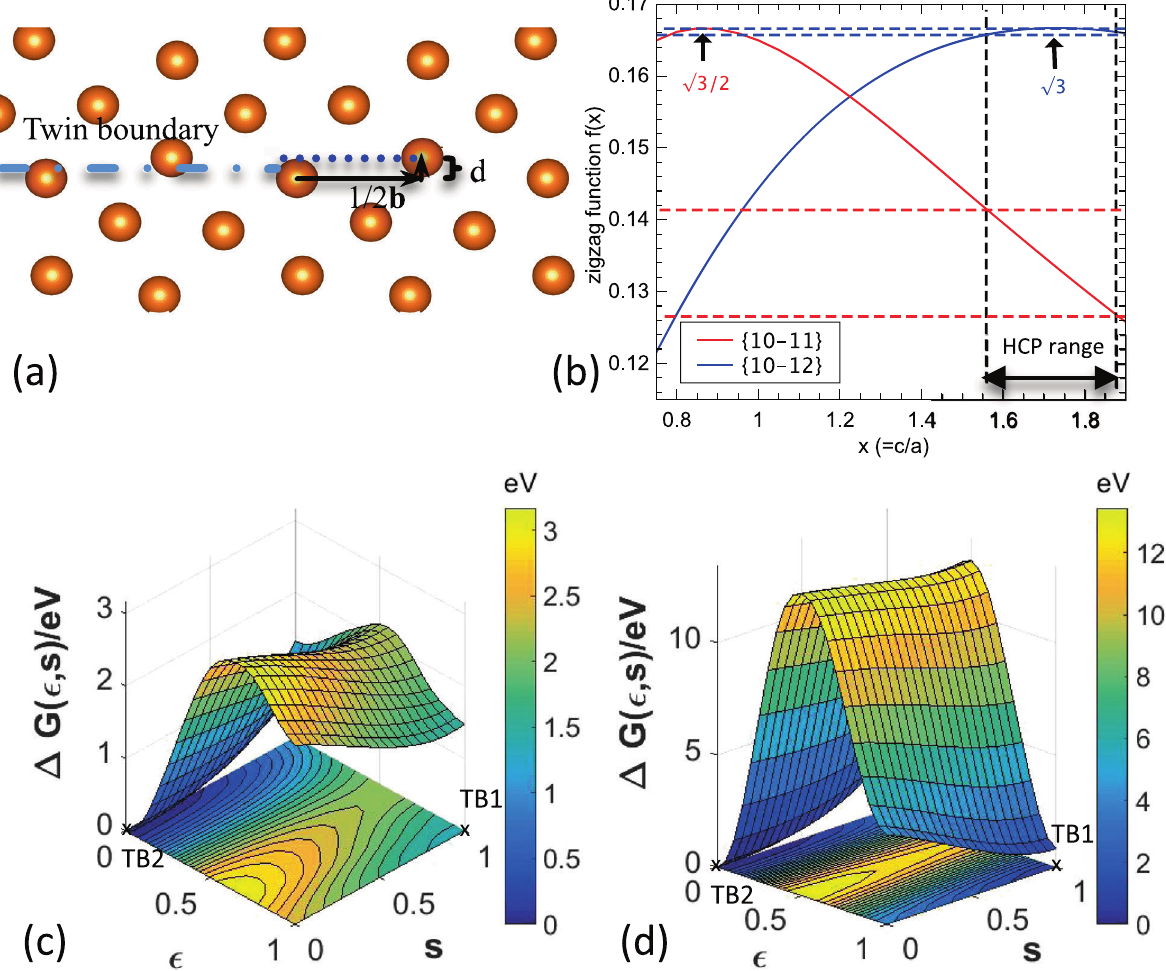
Fig. 2 The Gibbs energies for the f 1011 g compression c and f 1012 g tensile d twins in pure Mg computed by one Mg – Y EAM potential ! b developed by Pei et al. 19 De fi nitions of the two parameters, ε (cid:3) j 1 j (0 ≤ ε ≤ 1) and s·d (0 ≤ s ≤ 1) are illustrated in a . In both energy surfaces 2 there are only two local minima that correspond to the glide twin boundary (TB1) and re fl ection twin boundary (TB2), respectively. The zigzag functions for these two twins are shown in b . The c / a range for all hcp metals and maxima of zigzag functions are denoted by black arrows